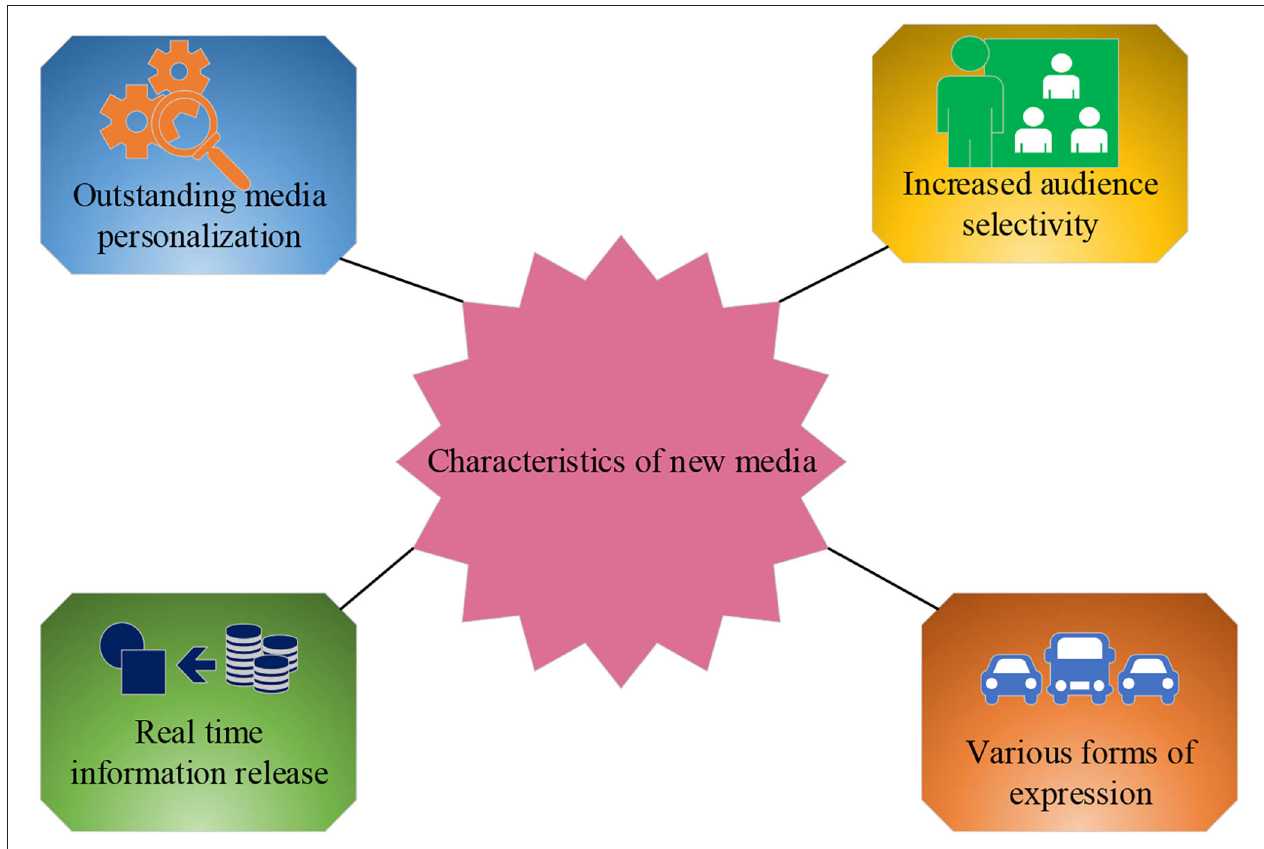
FIGURE 5 | The characteristics of the new